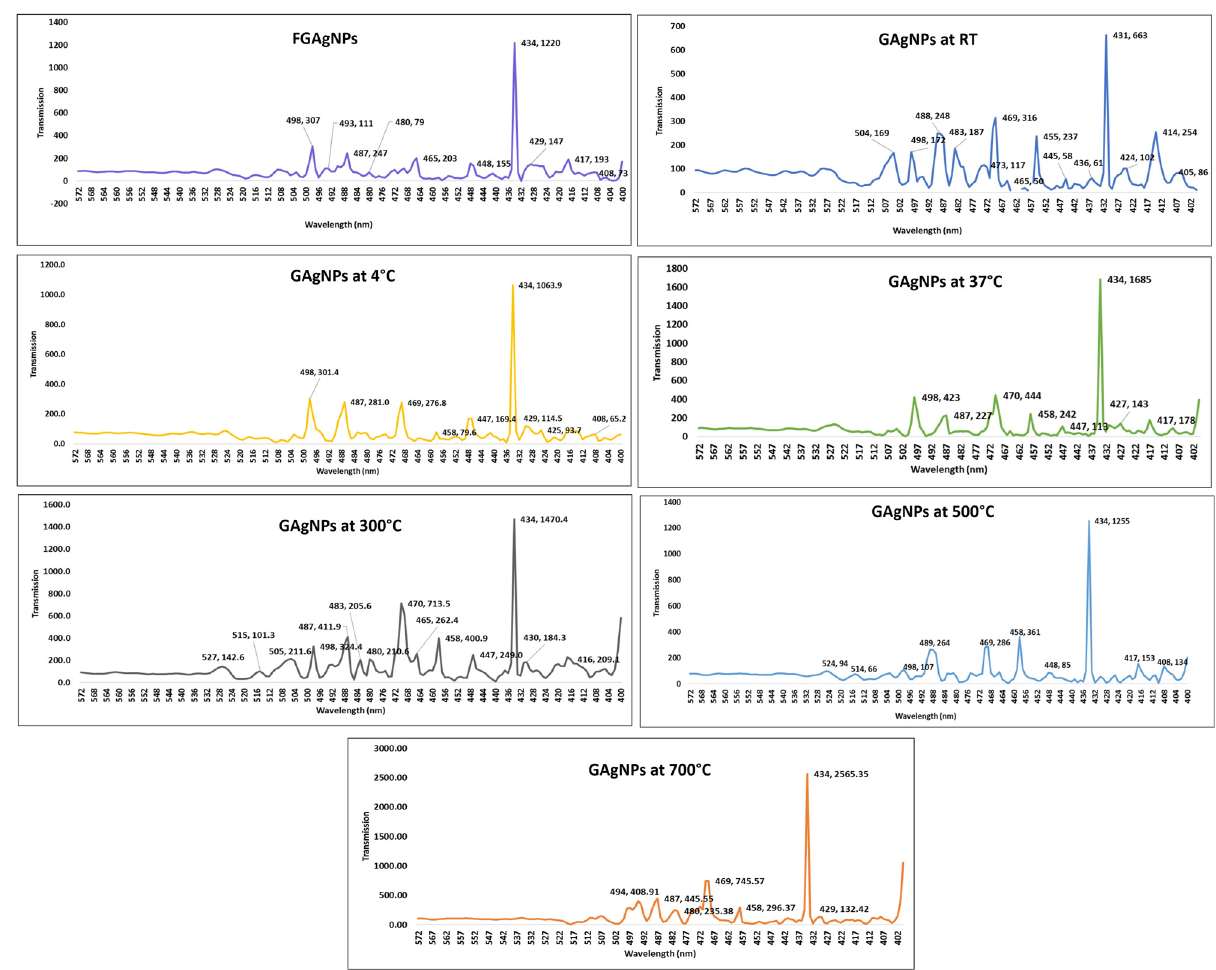
Figure 3: FTIR of green - synthesized silver nanoparticles using A. sativum clove